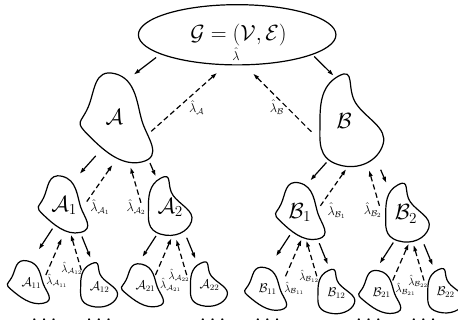
Figure 3. Illustration of the divide and conquer approach described in Algorithm 1. First, a binary tree with successive graph bisections is constructed (divide). The graph spectrum is reconstructed by stitching back together the pieces of the spectra of the reduced-size graphs